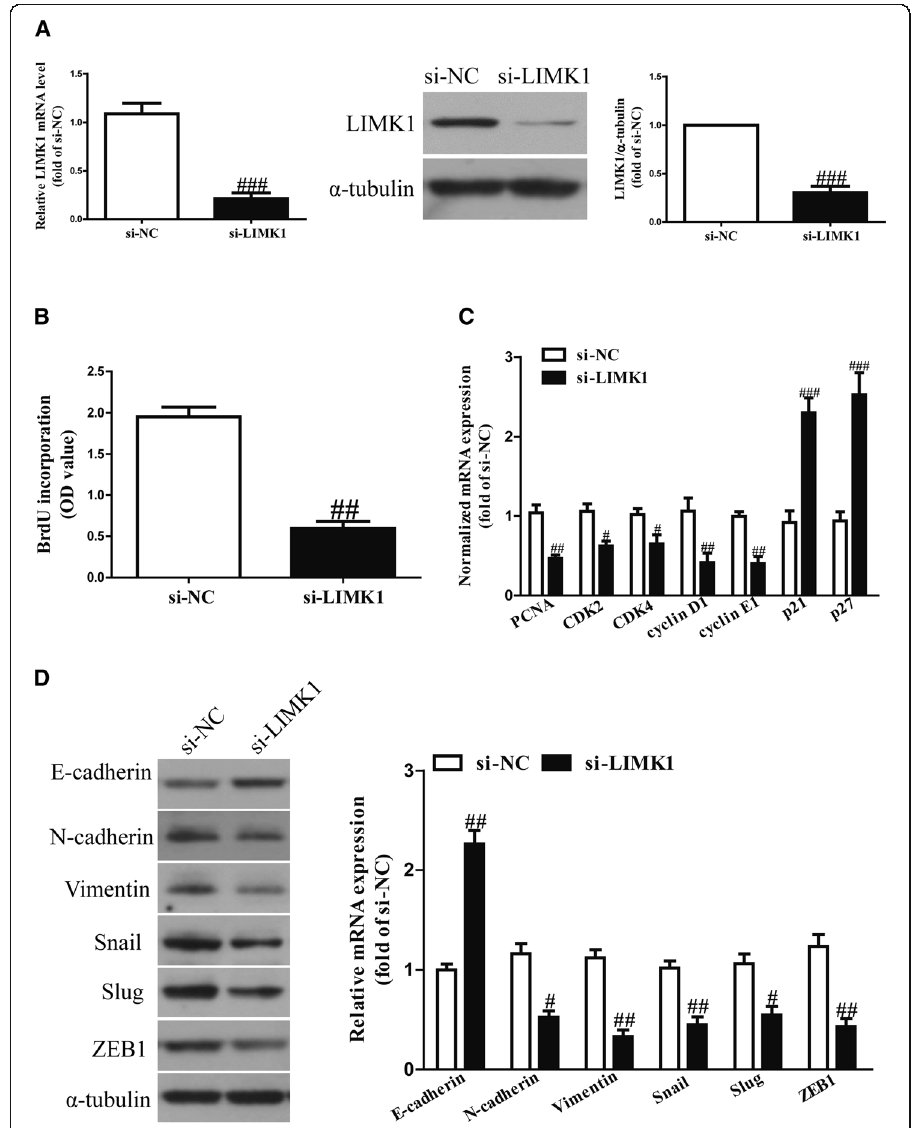
Fig. 2 The effects of LIMK1 silencing on the proliferation and EMT in OSCC cells. SCC4 cells were transfected with si-LIMK1 or si-NC for 48h. a The mRNA and protein expressions of LIMK1 were determined via quantitative RT-PCR and western blot, respectively. b Cell proliferation was assessed with a BrdU-ELISA assay. c The mRNA expressions of PCNA, CDK2, CDK4, cyclin D1, cyclin E1, p21 and p27 were determined via quantitative RT-PCR. d The expressions of E-cadherin, N-cadherin, vimentin, SNAIL, SLUG and ZEB1 were determined via quantitative RT-PCR and western blot assays, respectively. All data are presented as means ± SEM, n =6. # p <0.05, ## p <0.01 vs.